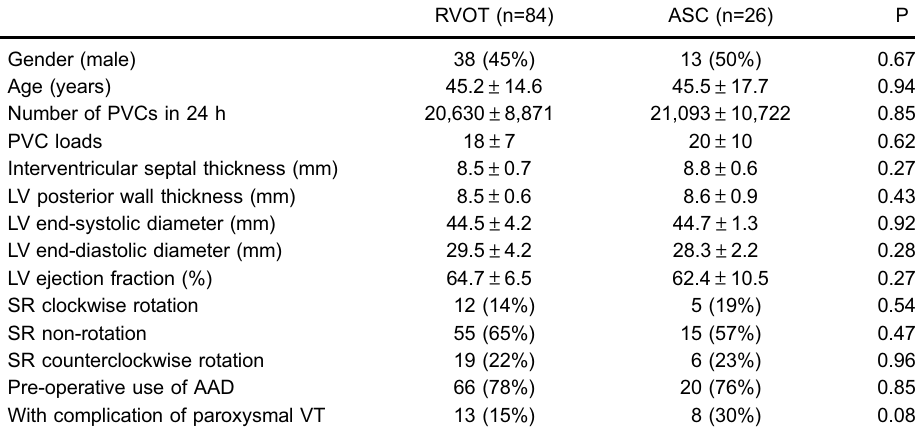
Table 1. General patient